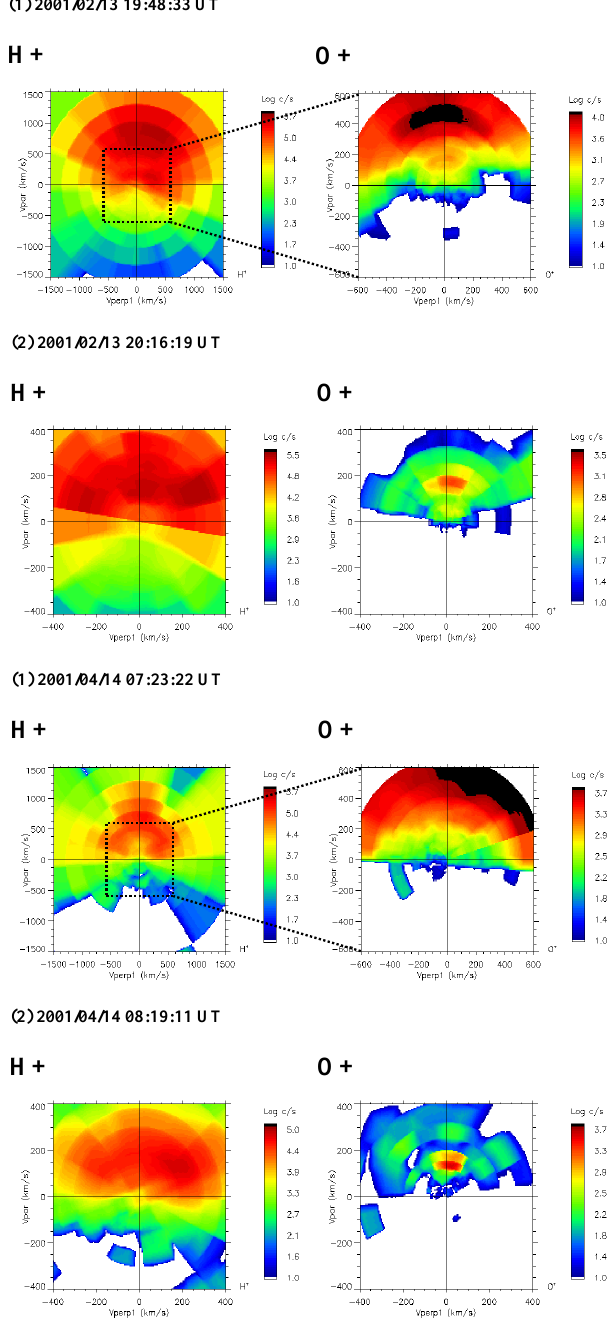
Fig. 8. Evolution of O + ion velocity distribution. The figures marked by (1) and different date are presumed to be velocity dis- tributions in the dayside cusp. The figures marked by (2) on the right hand are velocity distributions in the mantle region. O + ion velocity distributions are different in the dayside cusp or in the man- tle region: dome shape rather than shell configuration in the cusp, while pre-shell configuration in the